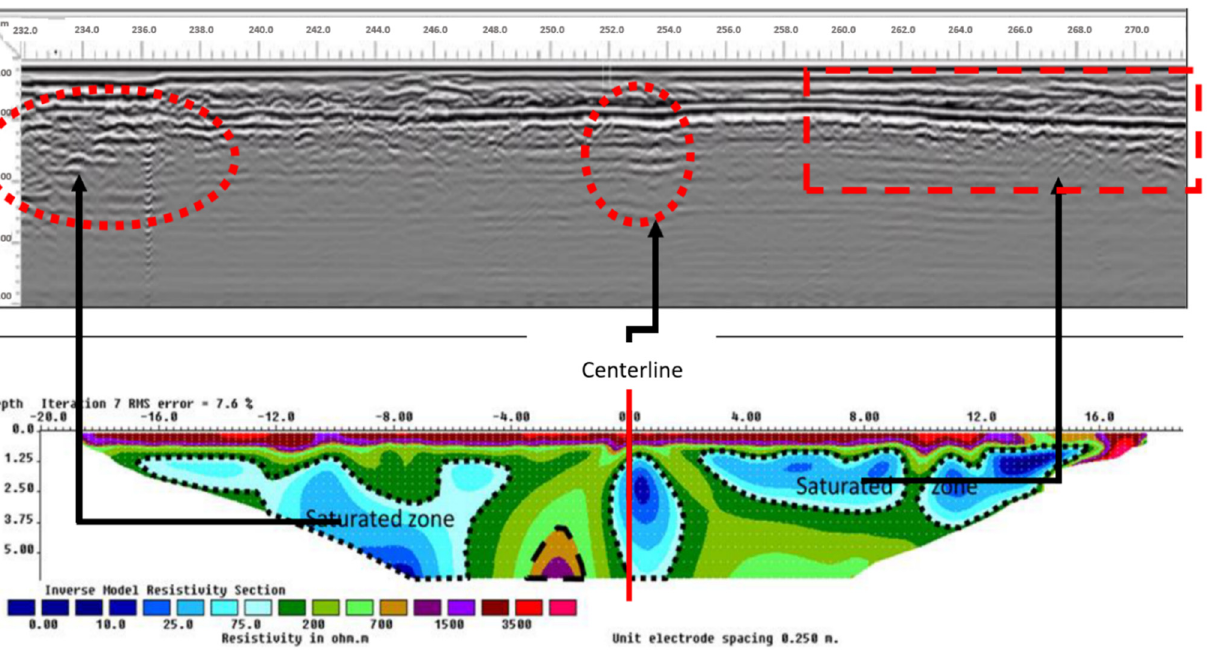
Figure 10. Two different methods exhibited in (Park et al., 2017): ( a ) the pole electrode method (PEM), and ( b ) the flat electrode method (FEM).